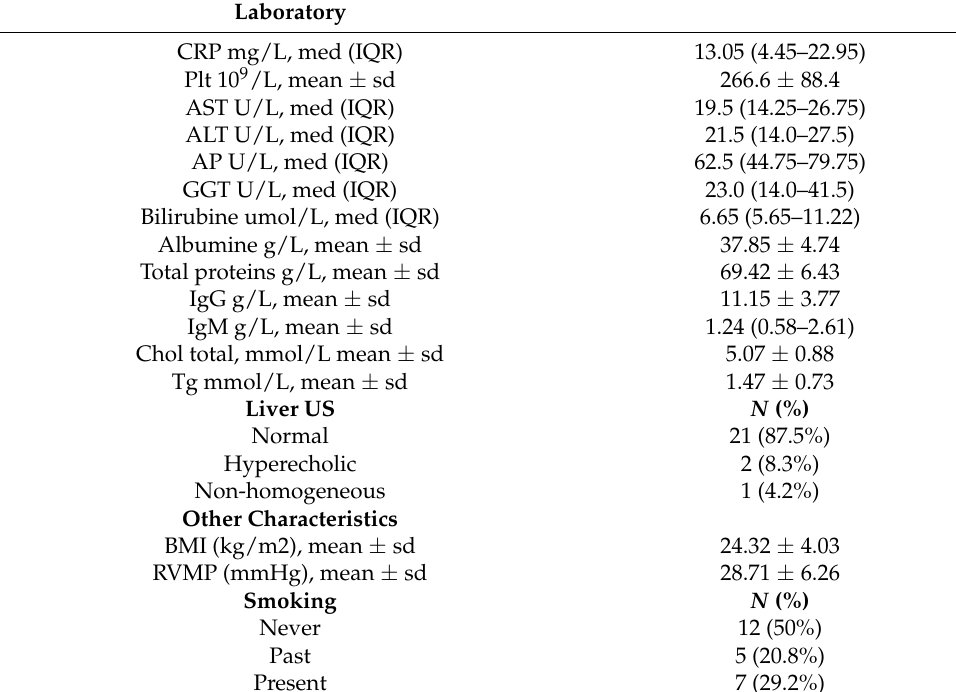
Table 2. Laboratory parameters, diagnostics, and other patients’ characteristics.